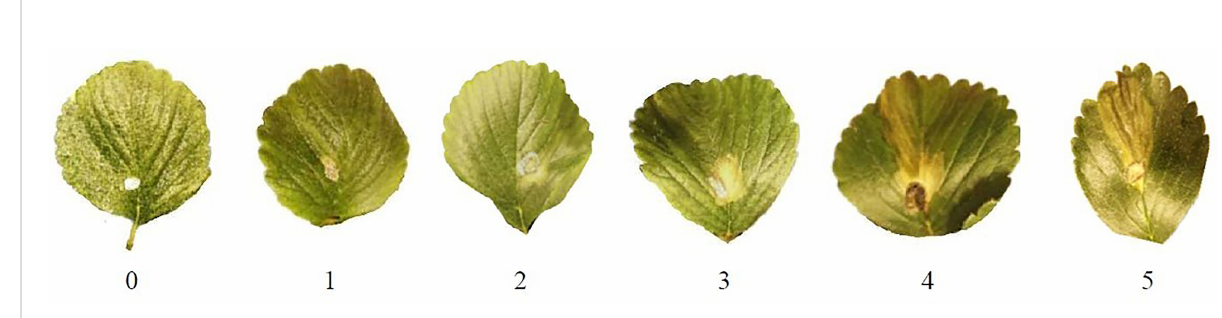
FIGURE 1 Grey mold severity scale on strawberry leaves suggested by the